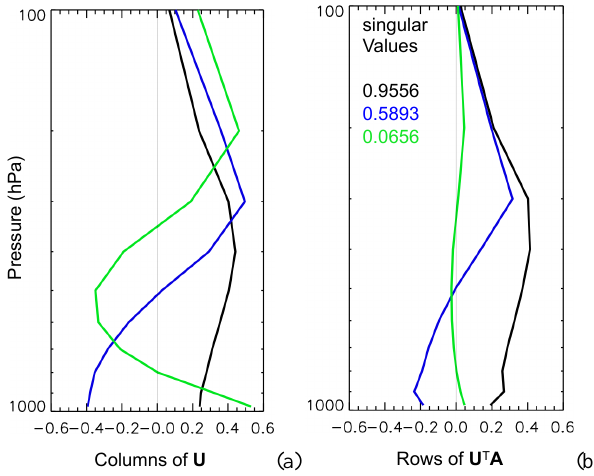
Fig. 5. (a) Left singular vector ( U ) from the SVD of the MOPITT 2006 CONUS average CO AK (first three ranked columns). (b) first Figure 5. (a) Left singular vector ( U ) from the SVD of the MOPITT Figure 5. (a) Left singular vector ( U ) from the SVD of the MOPITT three rows of the rotated average AK ( R ) with corresponding sin- 2006 CONUS average CO AK (1 st 3 ranked columns). (b) 1 st 3 rows 2006 CONUS average CO AK (1 st 3 ranked columns). (b) 1 st 3 rows gular values. of the rotated average AK ( R ) with corresponding singular values. of the rotated average AK ( R ) with corresponding singular values.